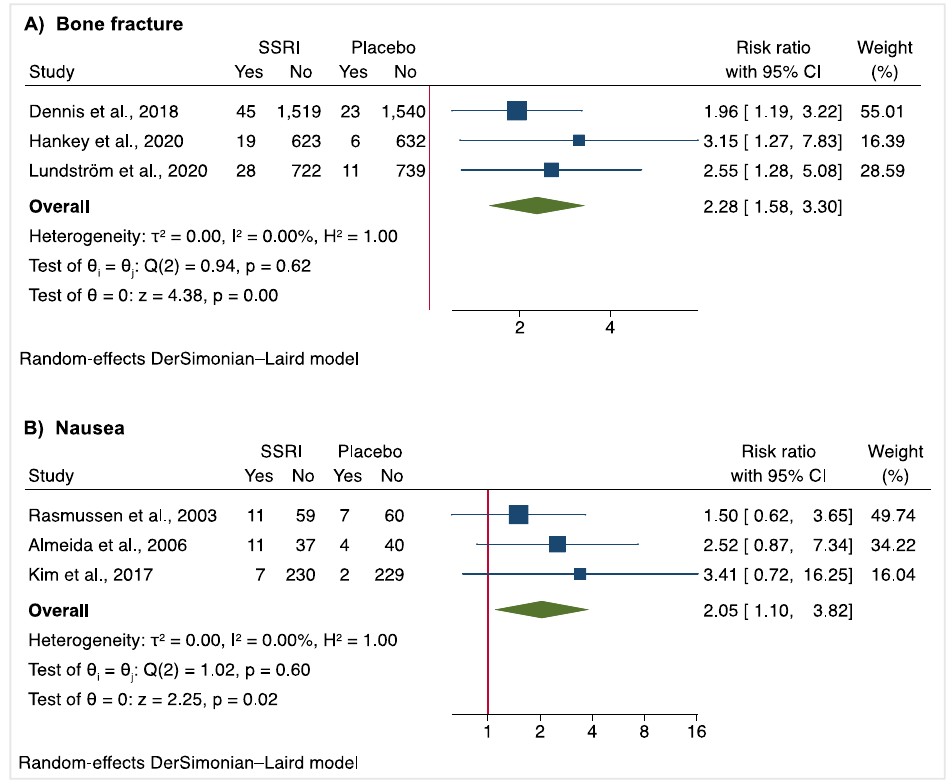
Figure 3. Forest plot of significant adverse events of SSRI treatment.